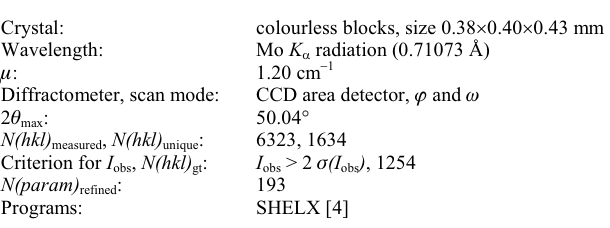
Table 1. Data collection and handling.